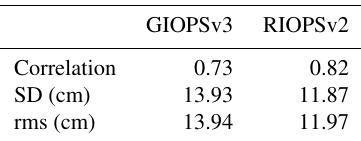
Figure 11. Innovation (observation–model) statistics of in situ tem- perature and salinity over the depth range 500–2000m for the pe- riod 1 January 2016 to 31 December 2018. The rms differences for temperature (a, b) and salinity (c, d) are shown for RIOPSv2 (a, c) and GIOPSv3 (b, d) . Table 3. SLA statistics for GIOPSv3 and RIOPSv2 compared to a particular Jason satellite altimetry track across the Gulf Stream (shown in Fig.